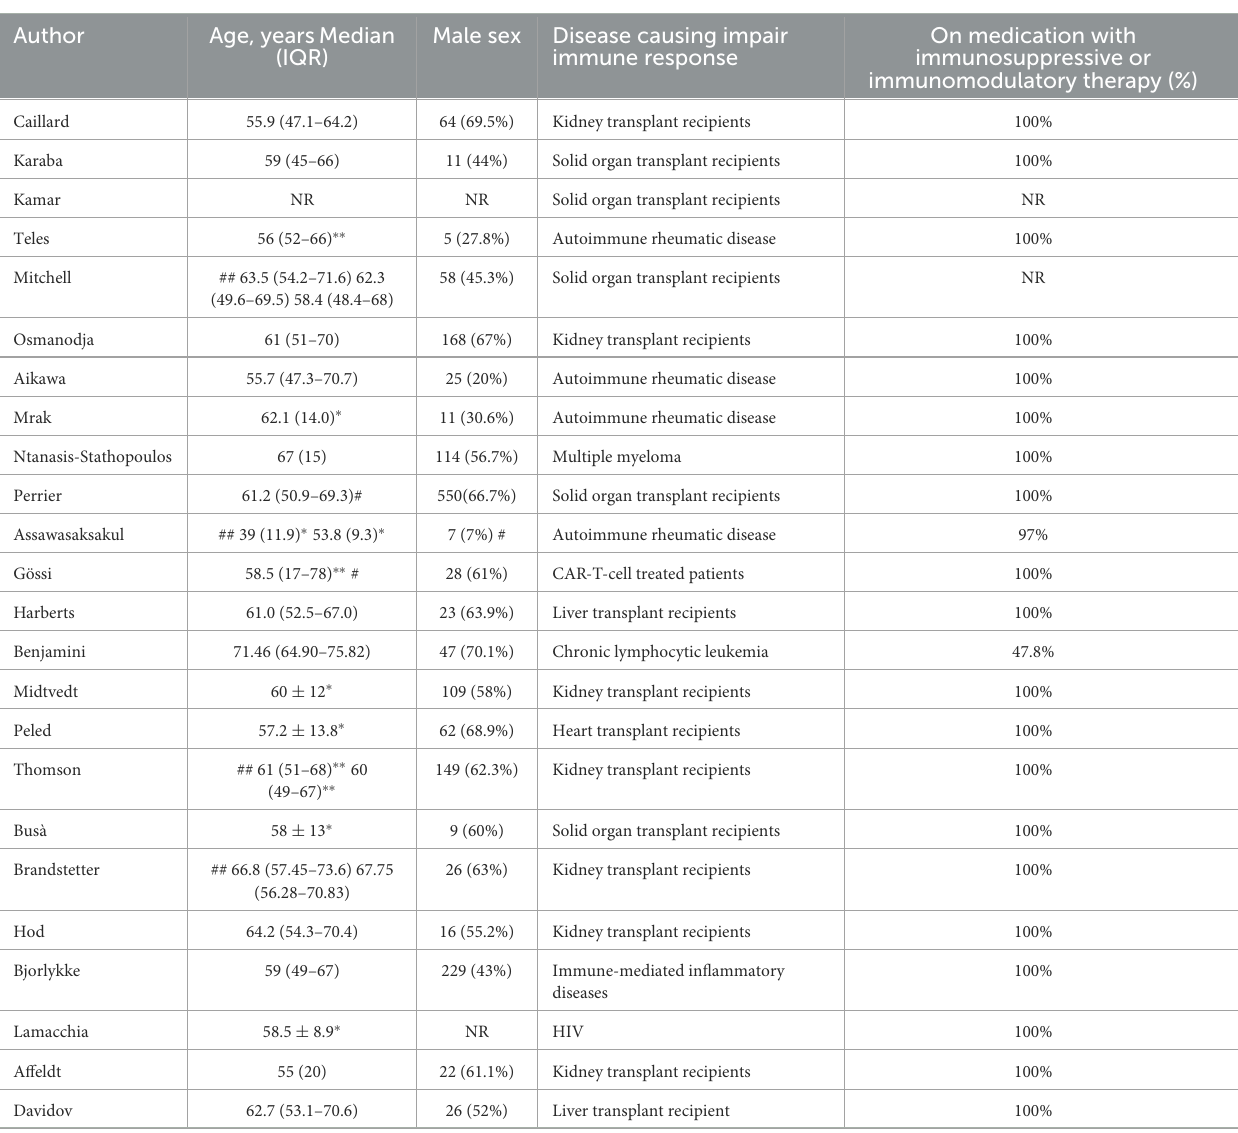
TABLE 3 Characteristics of the included